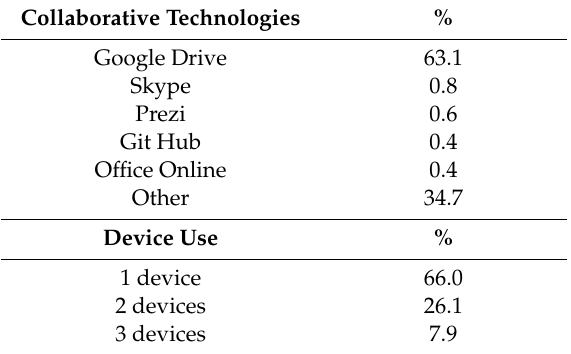
Table 8. Use of collaborative technologies and technological